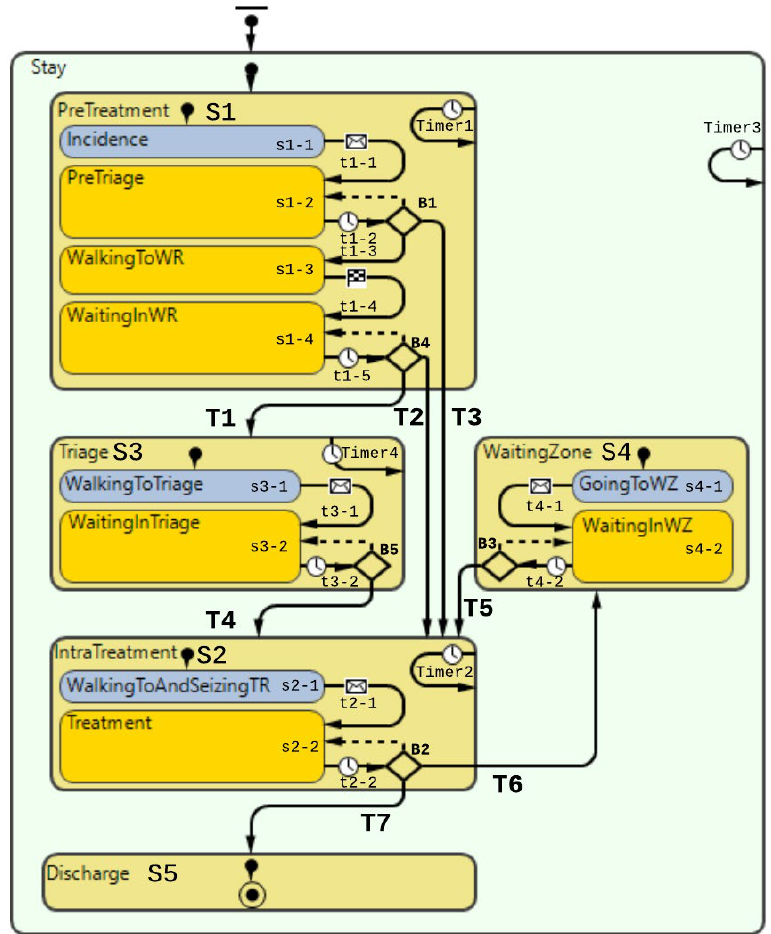
Figure 15. Statechart of patient flow behavior at the studied ED.